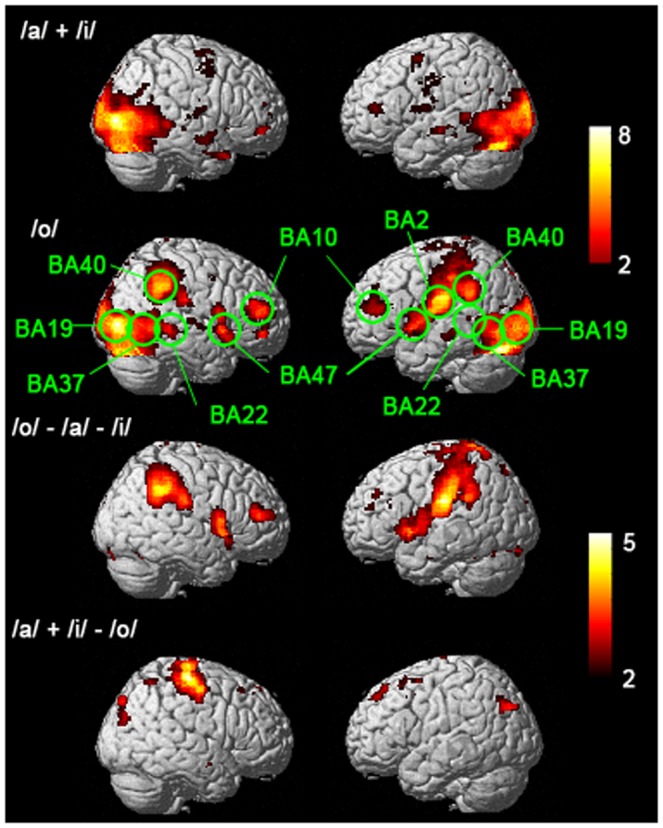
Brain areas significantly activated by viewing videoclips of face articulating non-target (/a/ and /i/) and target (/o/) vowels.The third row shows brain areas that were significantly more active in the target condition than in the non-target condition, and the fourth row the areas that were significantly more active in the non-target condition than the target condition, respectively. Color corresponds to the t statistics.